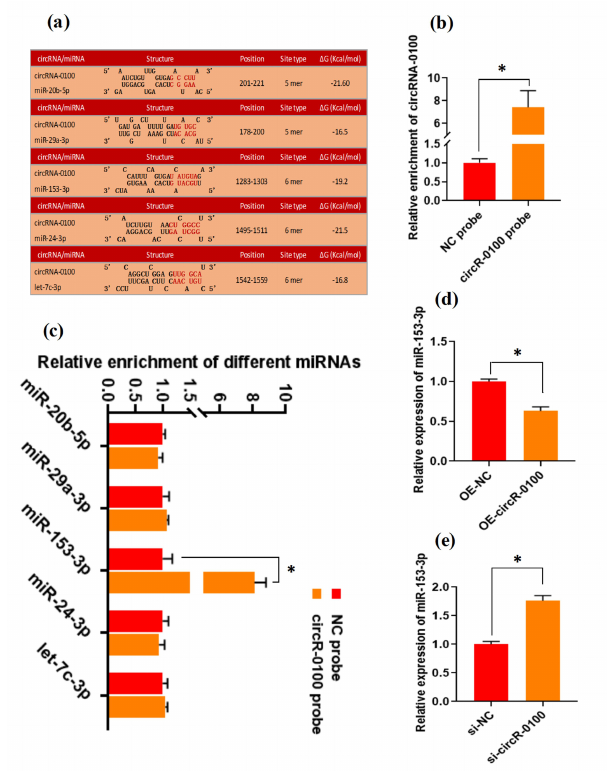
Figure 3. CircRNA-0100 sequesters miR-153-3p and regulates its expression in SHF-SCs of cashmere goats. (a) The predic- tion analysis of the binding sites of miR-20b-5p, miR-29a-3p, miR-153-3p, miR-24-3p, and let-7c-3p within circRNA-0100 se- quence. (b) Detecting results of circRNA-0100 in the pulled-down pellet by the circR-0100 probe and NC probe. (c) Detecting re- sults in the pulled-down pellet by the circR-0100 probe and NC probe. (d) Detecting results of miR-153-3p in SHF-SCs subjected to treatment with the circRNA-0100 overexpression assay. (e) De- tecting results of miR-153-3p in SHF-SCs subjected to treatment with the si-circR-0100 assay. NC probe: biotinylated negative con- trol probe group, circRNA-0100 probe: biotinylated circRNA-0100 probe group, OE-NC: negative control group, OE-circR-0100: over- expression circRNA-0100 groups, si-NC: negative control group, and si-circR-0100: knockdown group of circRNA-0100. The error bar represents the standard deviation within the group. ∗ represents significant difference ( P< 0 .